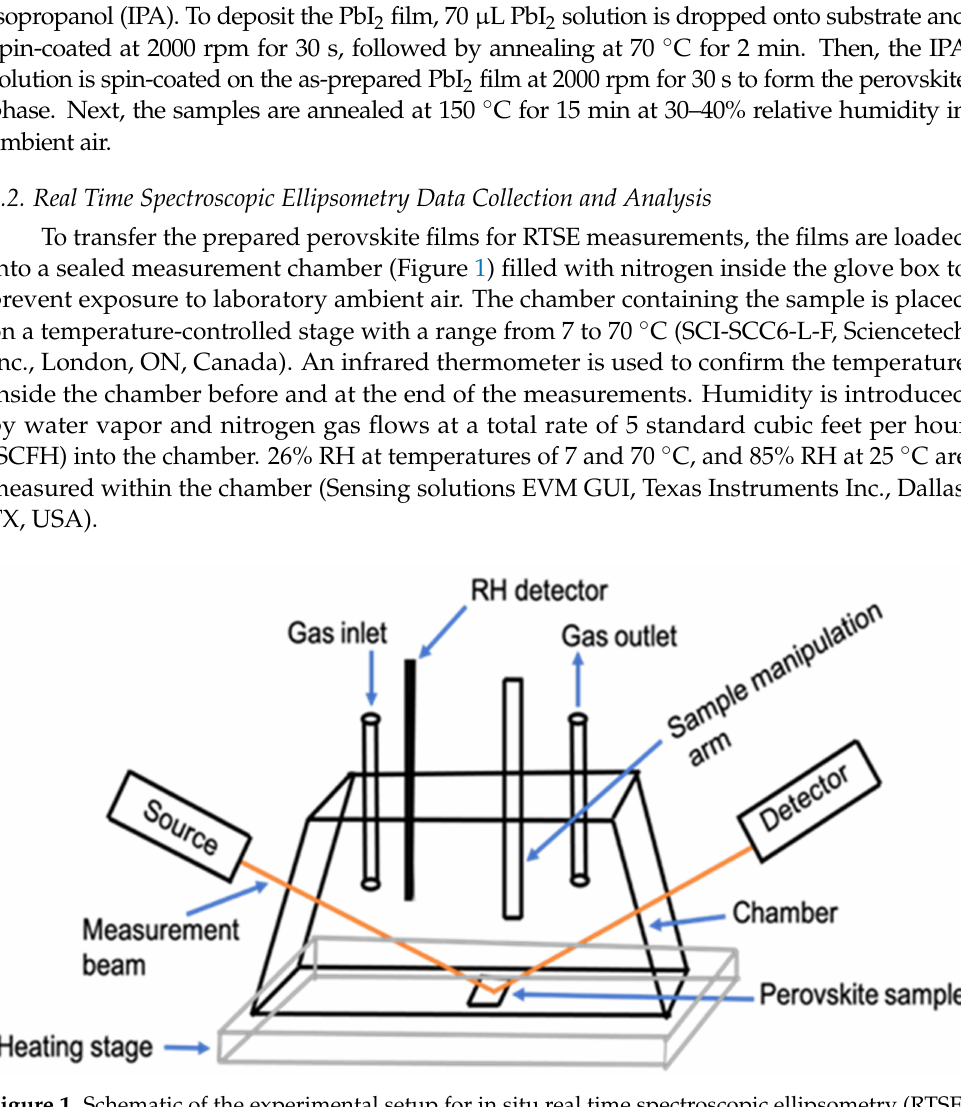
Figure 1. Schematic of the experimental setup for in situ real time spectroscopic ellipsometry (RTSE) data